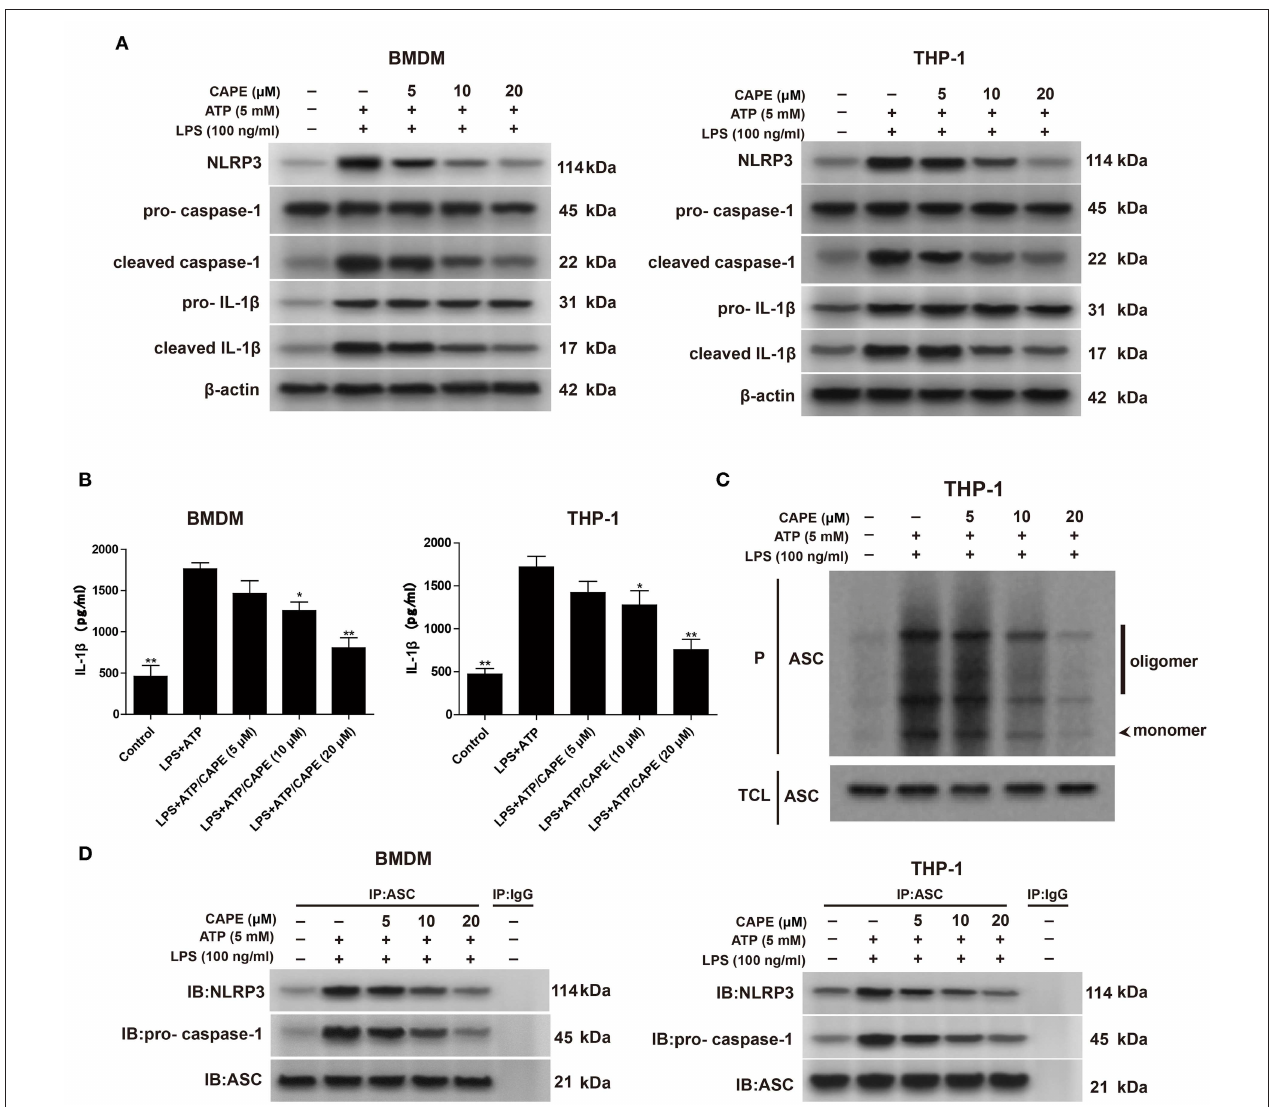
FIGURE 1 | CAPE decreases the activation of NLRP3 inflammasome in BMDMs and THP-1 cells. (A) Effect of CAPE on the expression of NLRP3, cleaved caspase-1, pro-caspase-1, cleaved IL-1 β and pro-IL-1 β in BMDMs and THP-1 cells. (B) ELISA for IL-1 β in supernatants from the indicated groups. (C) ASC polymerisation (oligomerization) was analyzed by Western blotting. (D) Coimmunoprecipitation assay using cell lysates from the indicated groups for analyzing the interaction between ASC and NLRP3 or between ASC and pro-caspase-1. Data are presented as mean ± SD ( n = 3). * P < 0.05, ** P < 0.01 vs. LPS + ATP